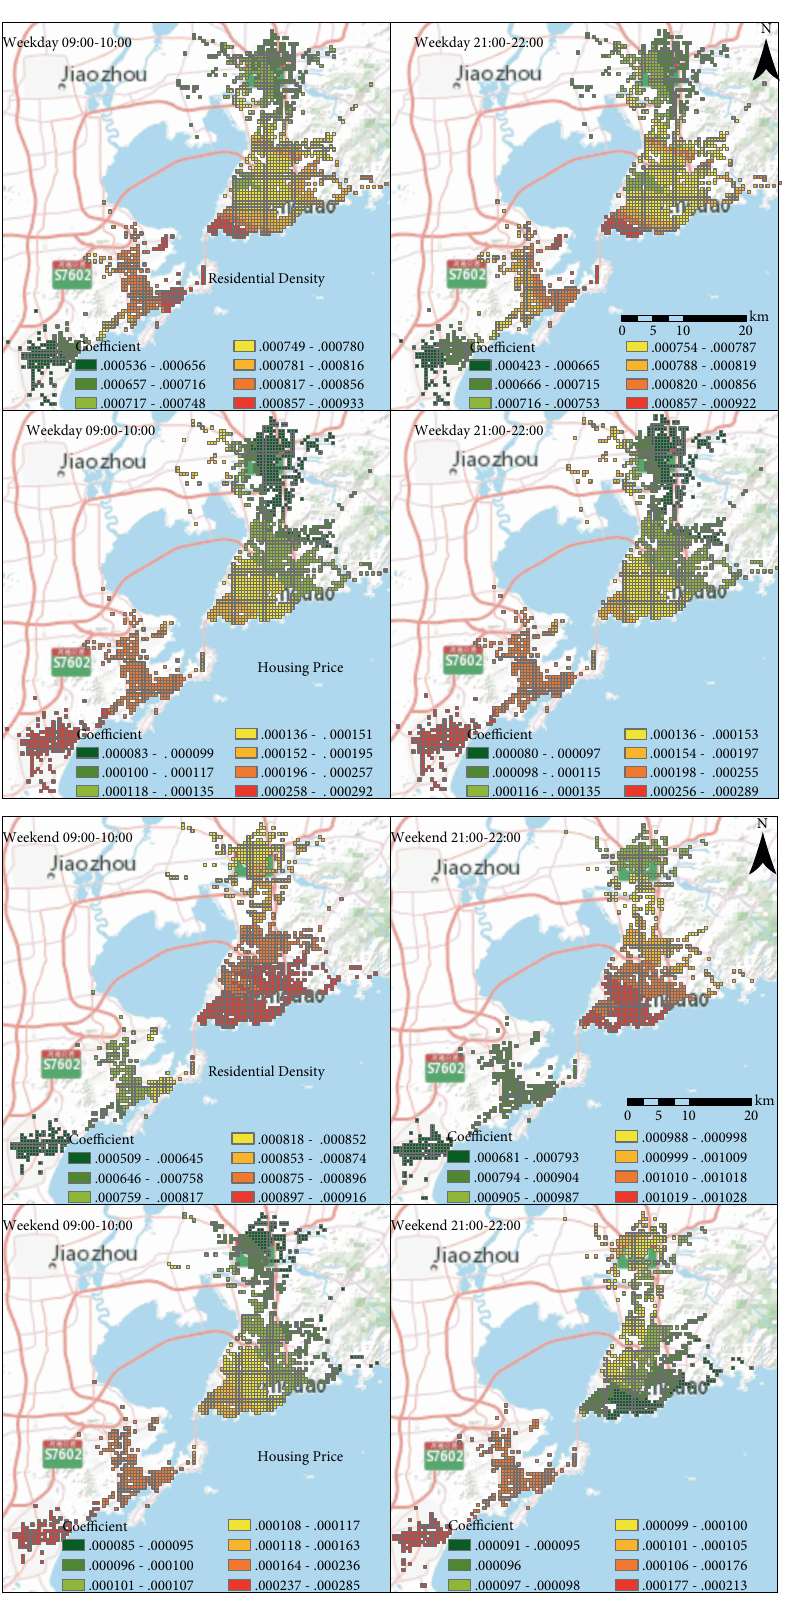
Figure 8: Spatial distribution for the coefficients of socio-economic factors for weekday and